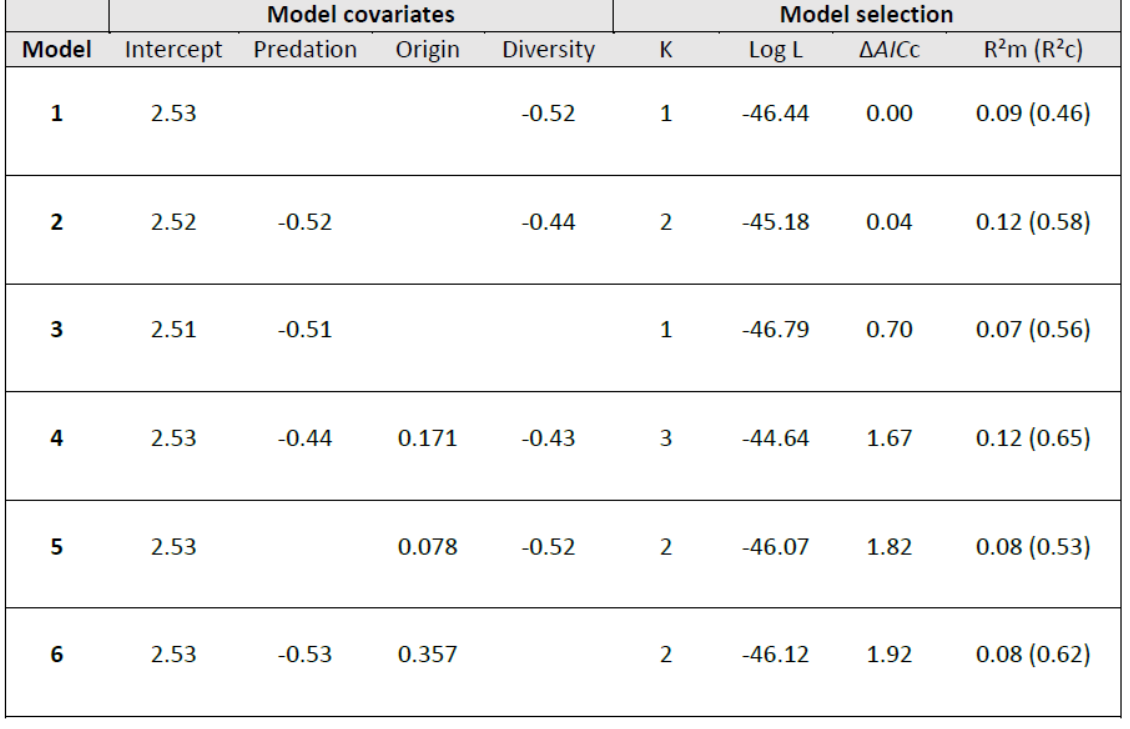
Table 2. Summary results of model selection of tree neighbourhood effect on herbivory rate: set of models with ΔAICc < 2. Only predictors that were present at least once in the set of best models are represented. R²m and R²c represent fixed and fixed plus random factor, respectively.